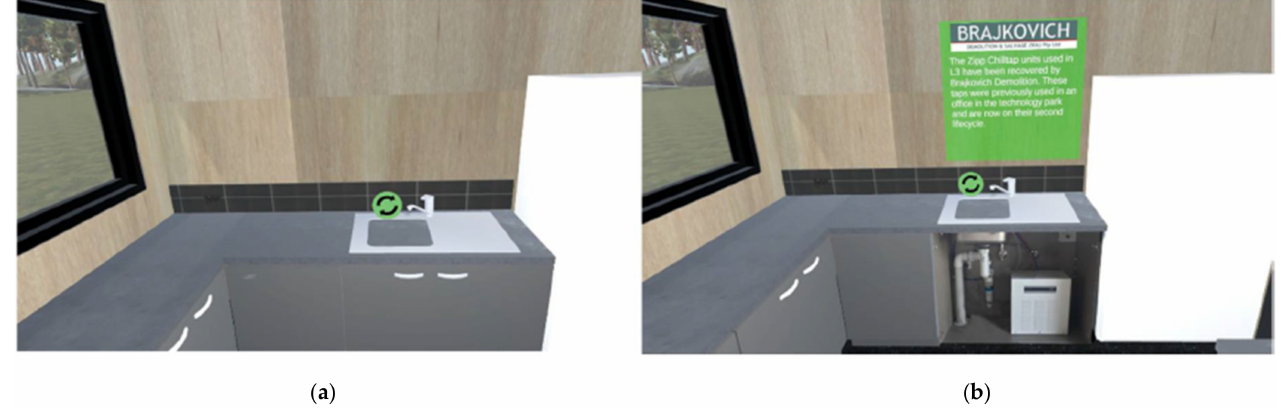
Figure 8. ( a ) The recycling logo prompts participants to learn about the provenance of the water chiller and filtration used within L3. ( b ) On the right, the figure shows the salvaged component within the VR model.